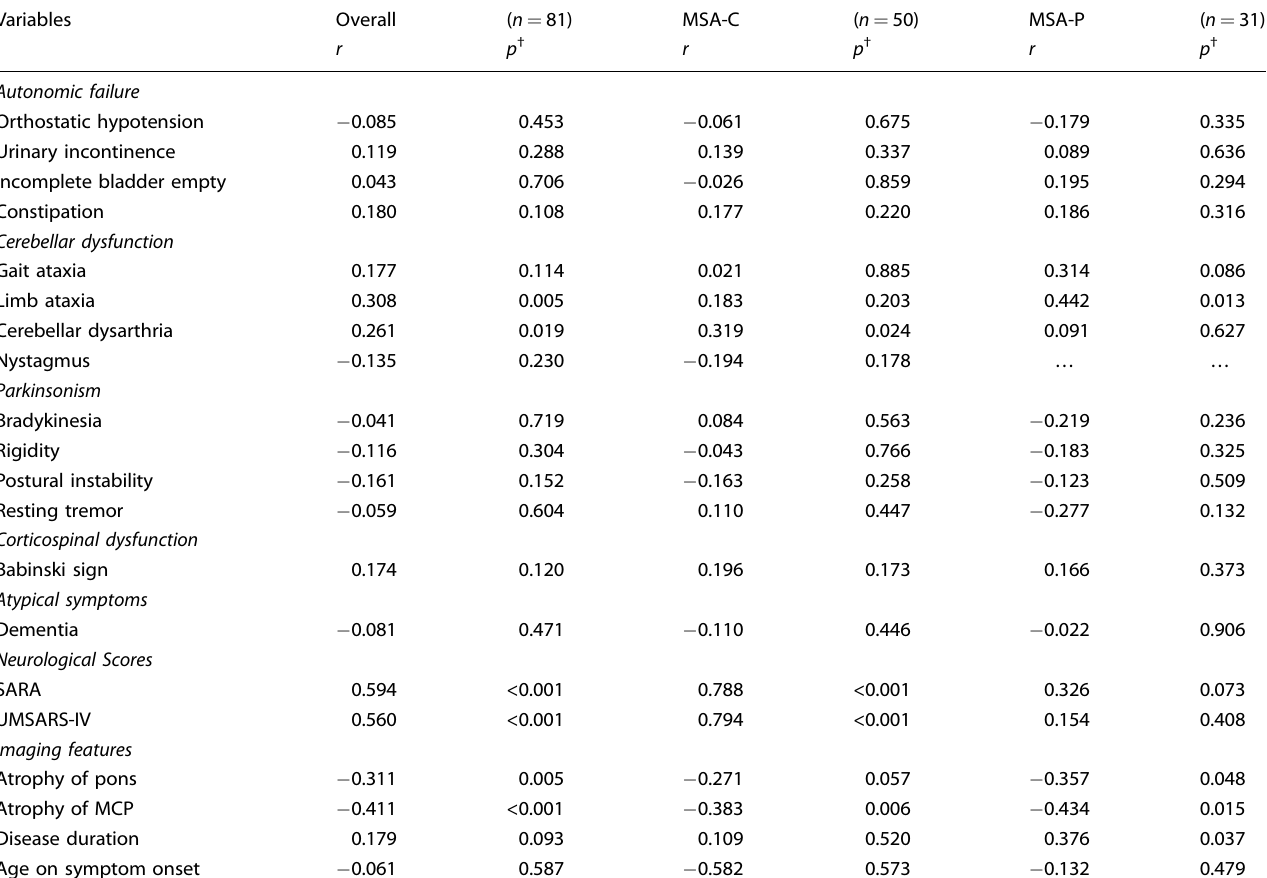
Table 3. Correlation analysis of HCBs grade with variables in MSA